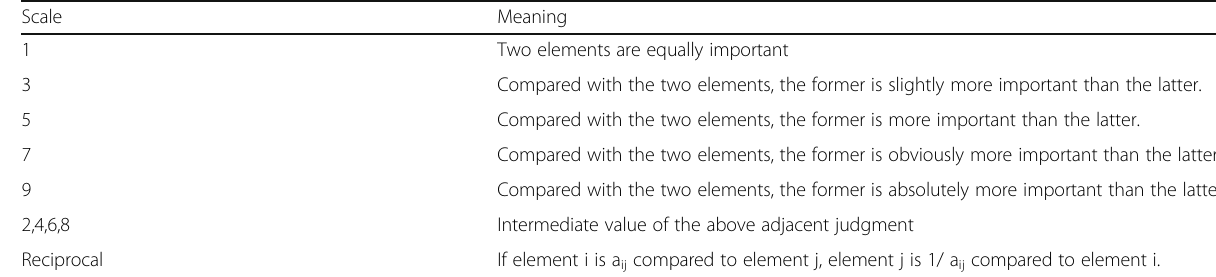
Table 5 Scale of relative importance of elements. (Source: Authors) Scale